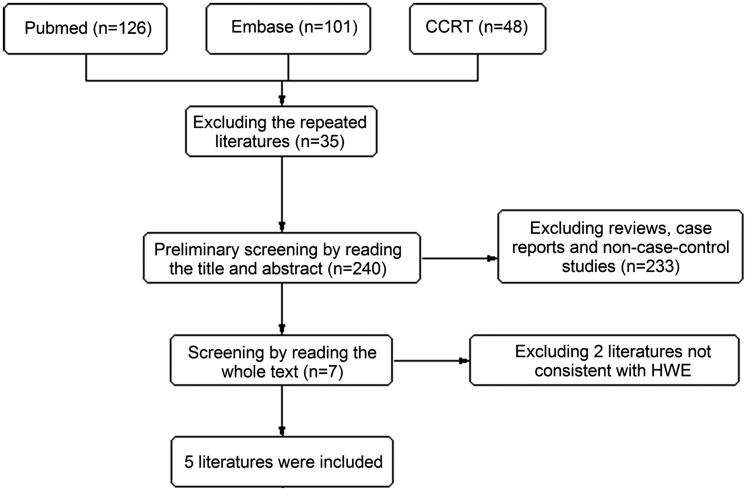
Flowchart on the selection of the literatures.